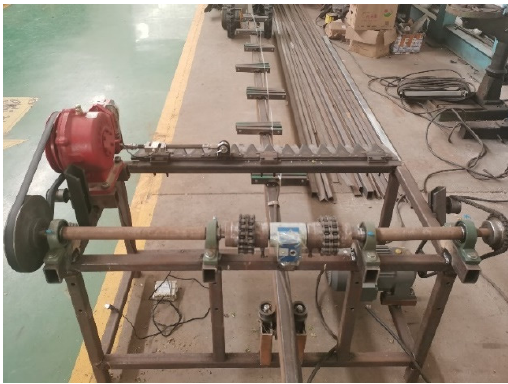
Figure 6. Design drawing of the test bed.